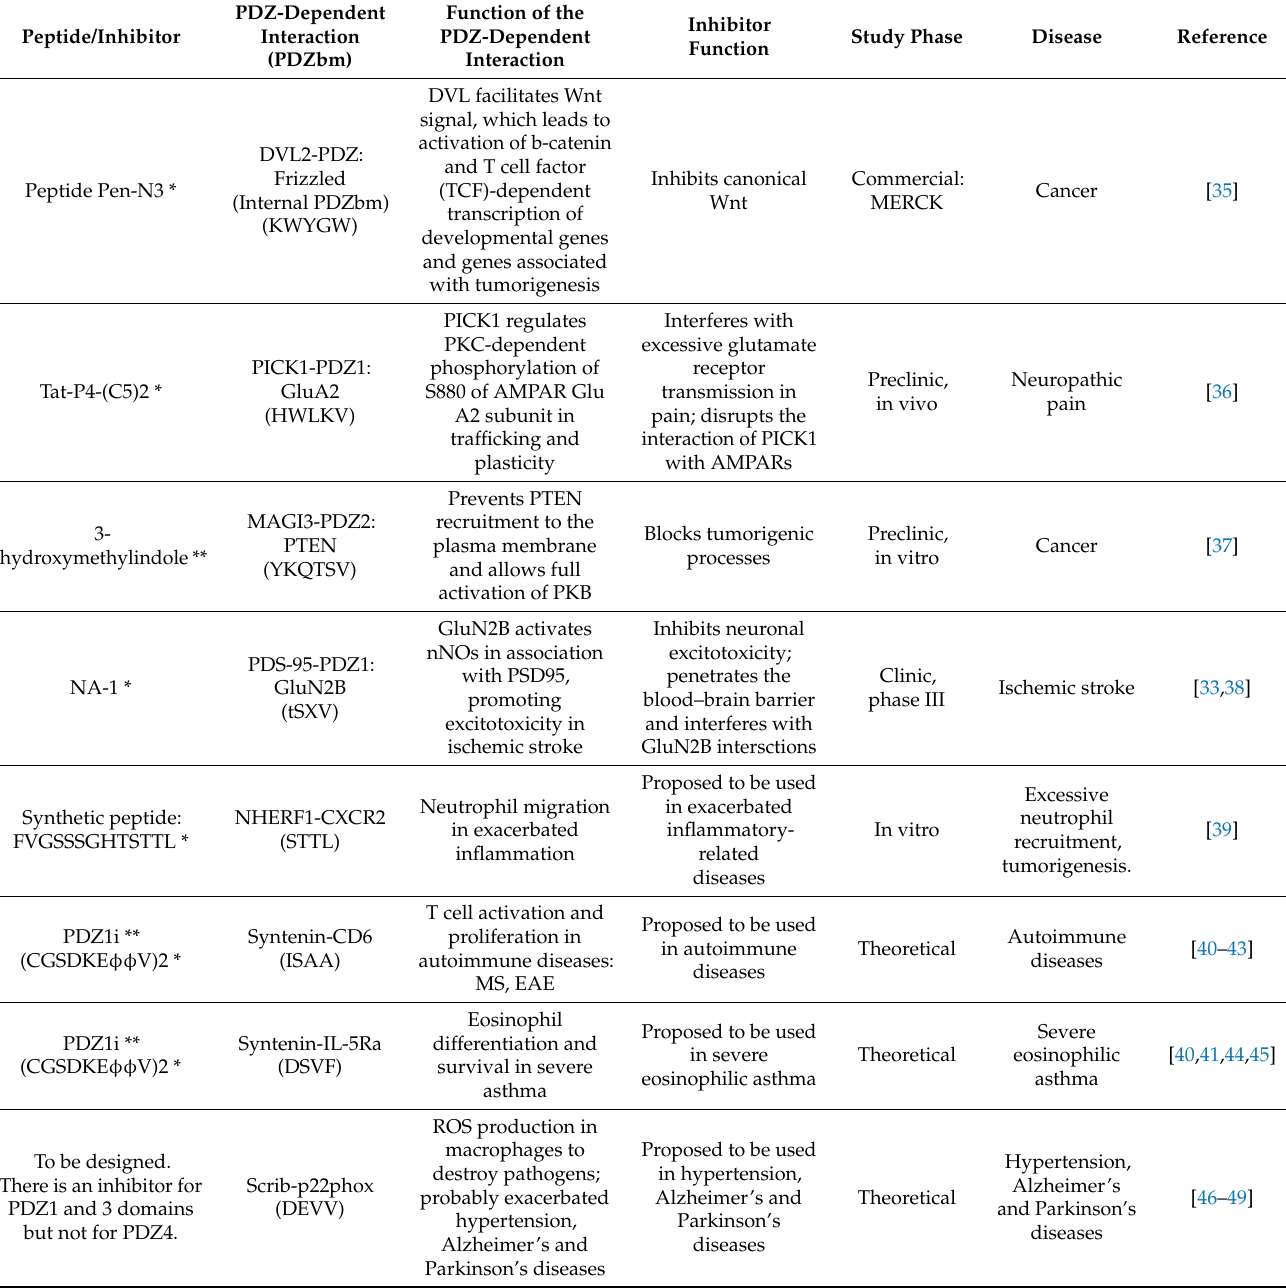
Table 1. Blockers of PDZ-dependent interactions with therapeutic